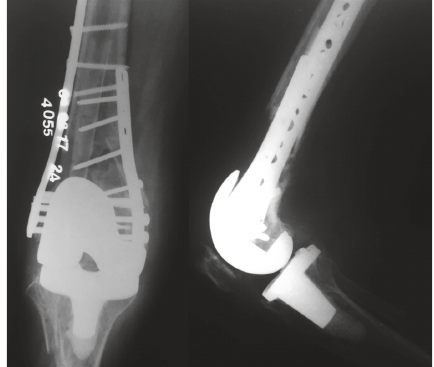
Figure 3: Final follow-up radiographs showing osseointegration of the fibular graft with definite bridging of the distal metaphyseal femur defect.